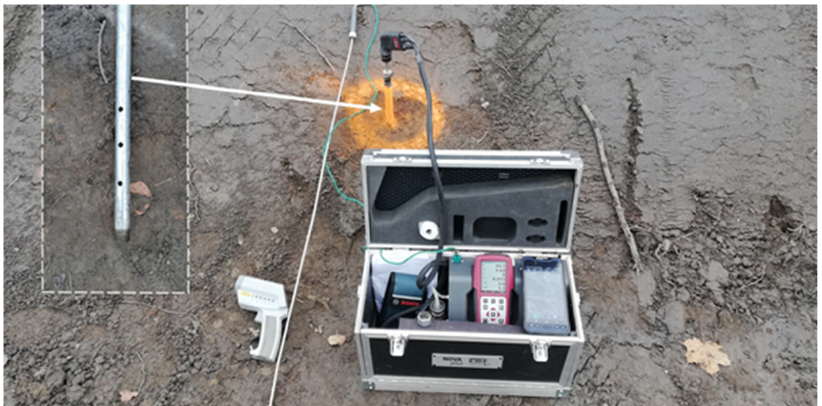
Figure 14. Measurement point as part of thermal condition monitoring (own elaboration).